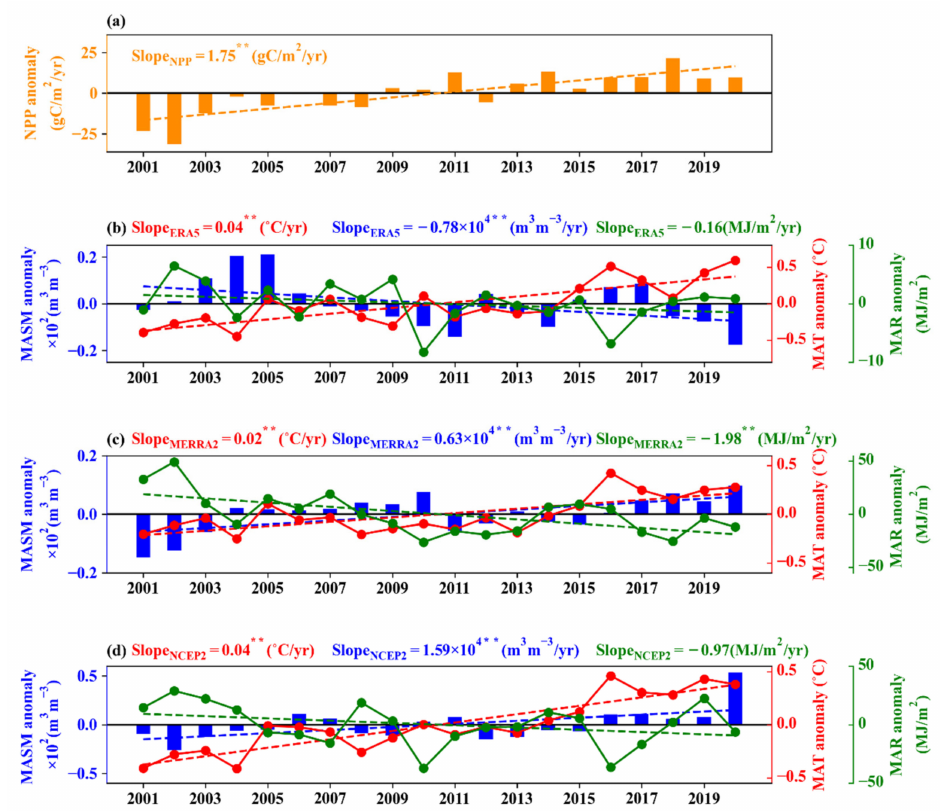
Figure 2. Trend of the NPP ( a ), MAT, MAR, and MASM ( b – d ) anomaly from 2001 to 2020. The dashed straight lines denote the trendlines in subfigure ( a ). Asterisks (**) denote that the slope is statistically significant at the 0.01 level.